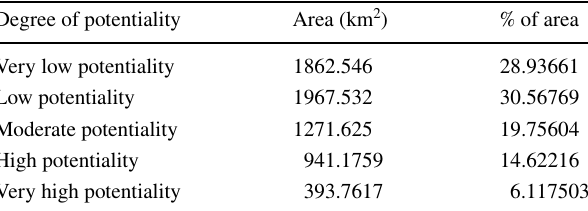
Table 7 Areal coverage of different groundwater potential zones within Kangsabati River basin